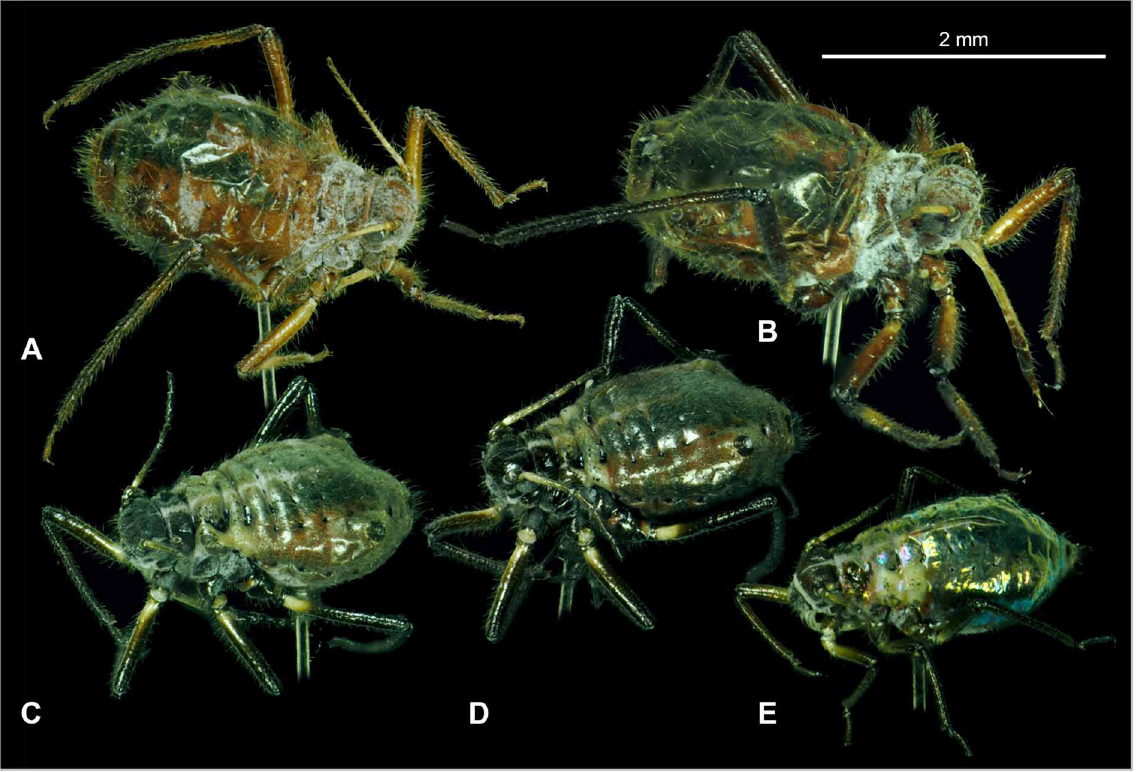
Fig. 109. Cinara (Cinara) hyperophila (Koch, 1855). Freeze-dried material. A–B . Adult apterae C–E . Juvenile